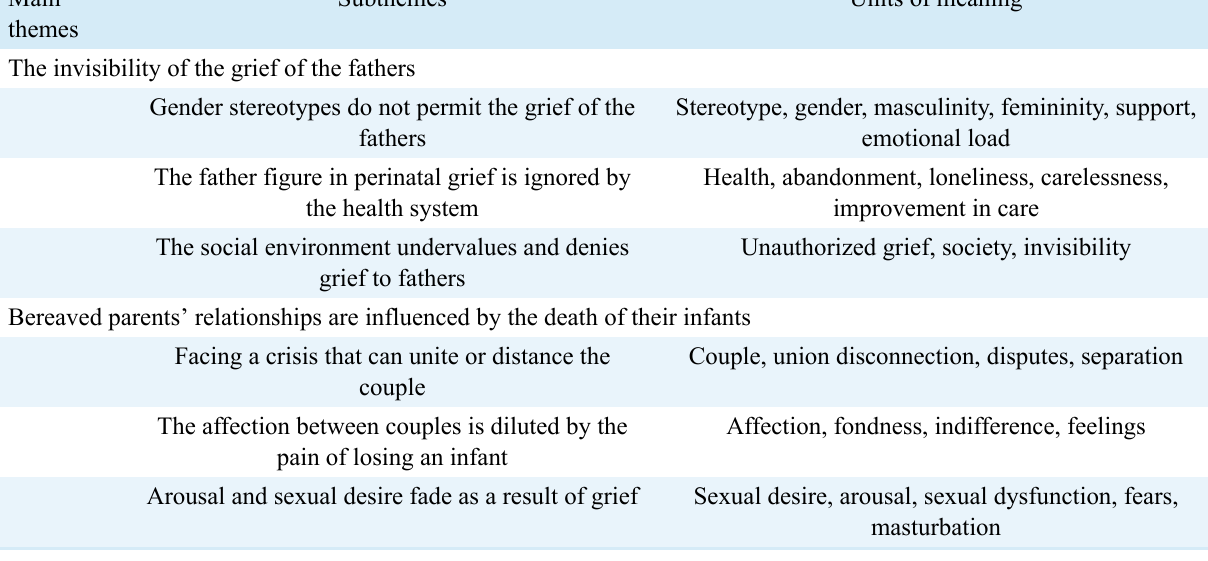
TABLE 3. Research results grouped into subthemes and main